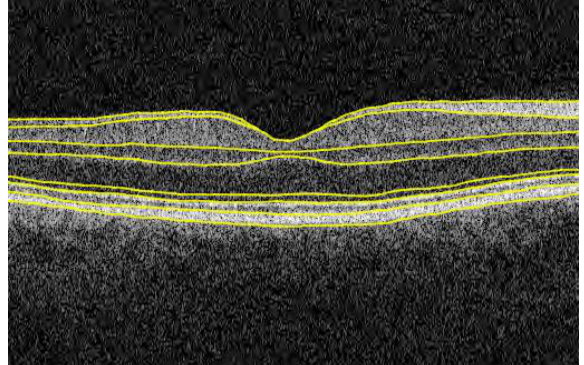
Figure 1. Schematic diagram of macular retinal nerve fiber layer in spectral-domain optical coherence tomography images. he top two lines refer to the inner limiting membrane and inner surface of ganglion cell layer. Areas between these two lines refer to the macular retinal nerve fiber layer.